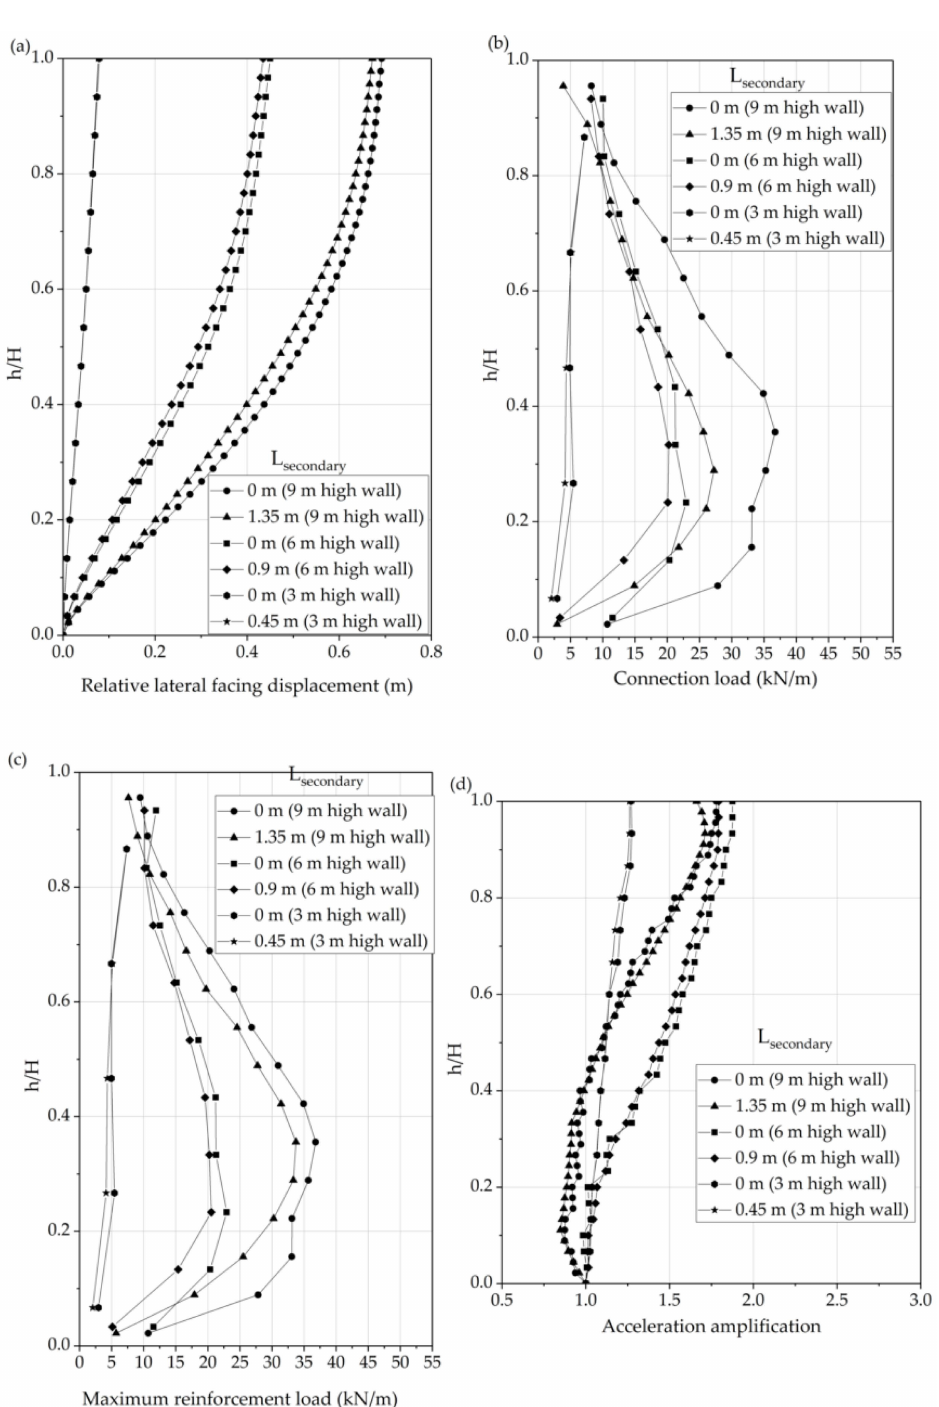
Figure 17. The e ff ect of wall height on ( a ) the relative lateral facing displacement; ( b ) connection load; ( c) maximum reinforcement load; ( d ) the acceleration amplification of the wall with and without secondary